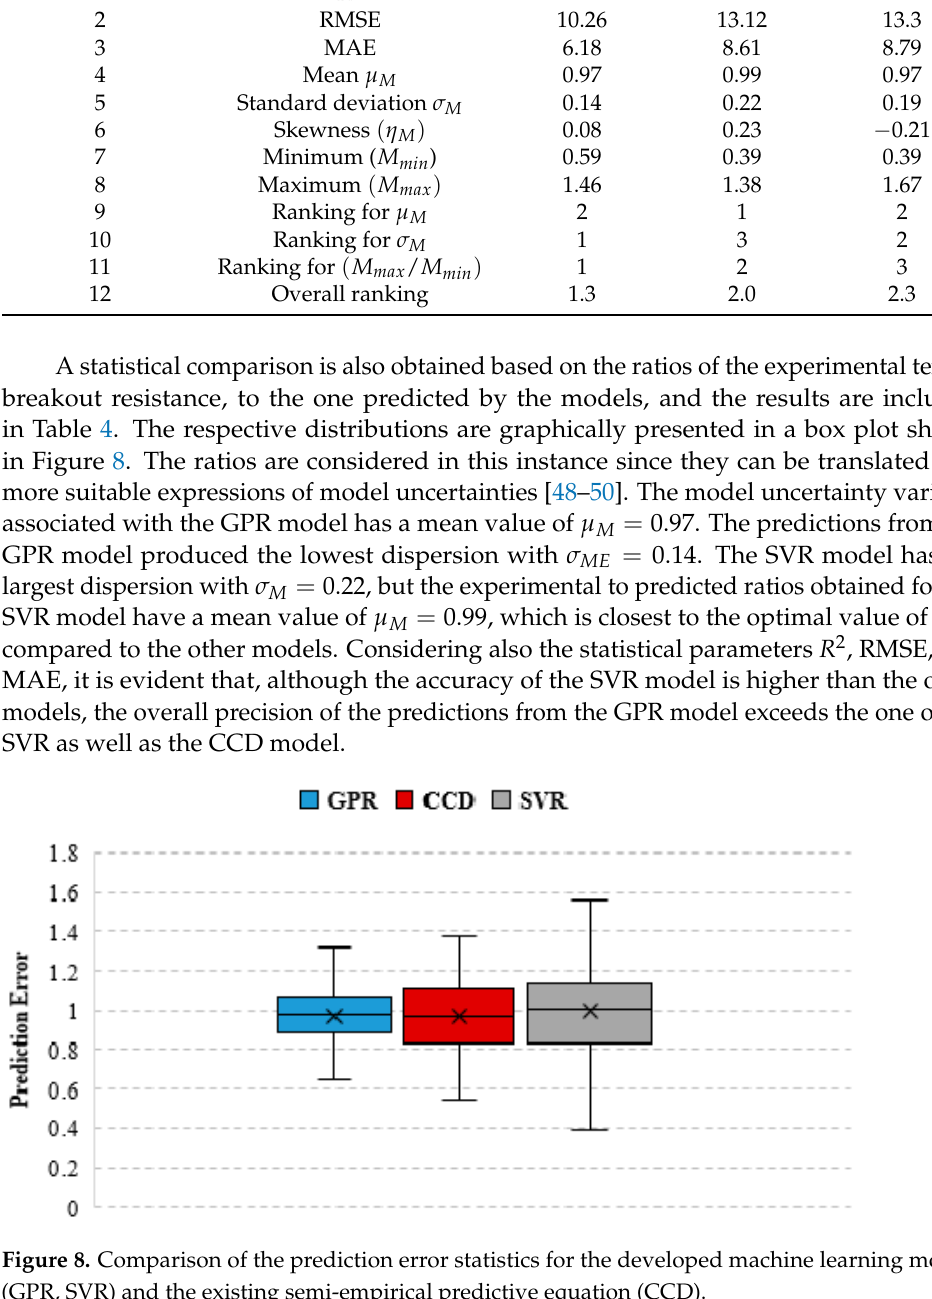
Figure 8. Comparison of the prediction error statistics for the developed machine learning models (GPR, SVR) and the existing semi-empirical predictive equation (CCD).